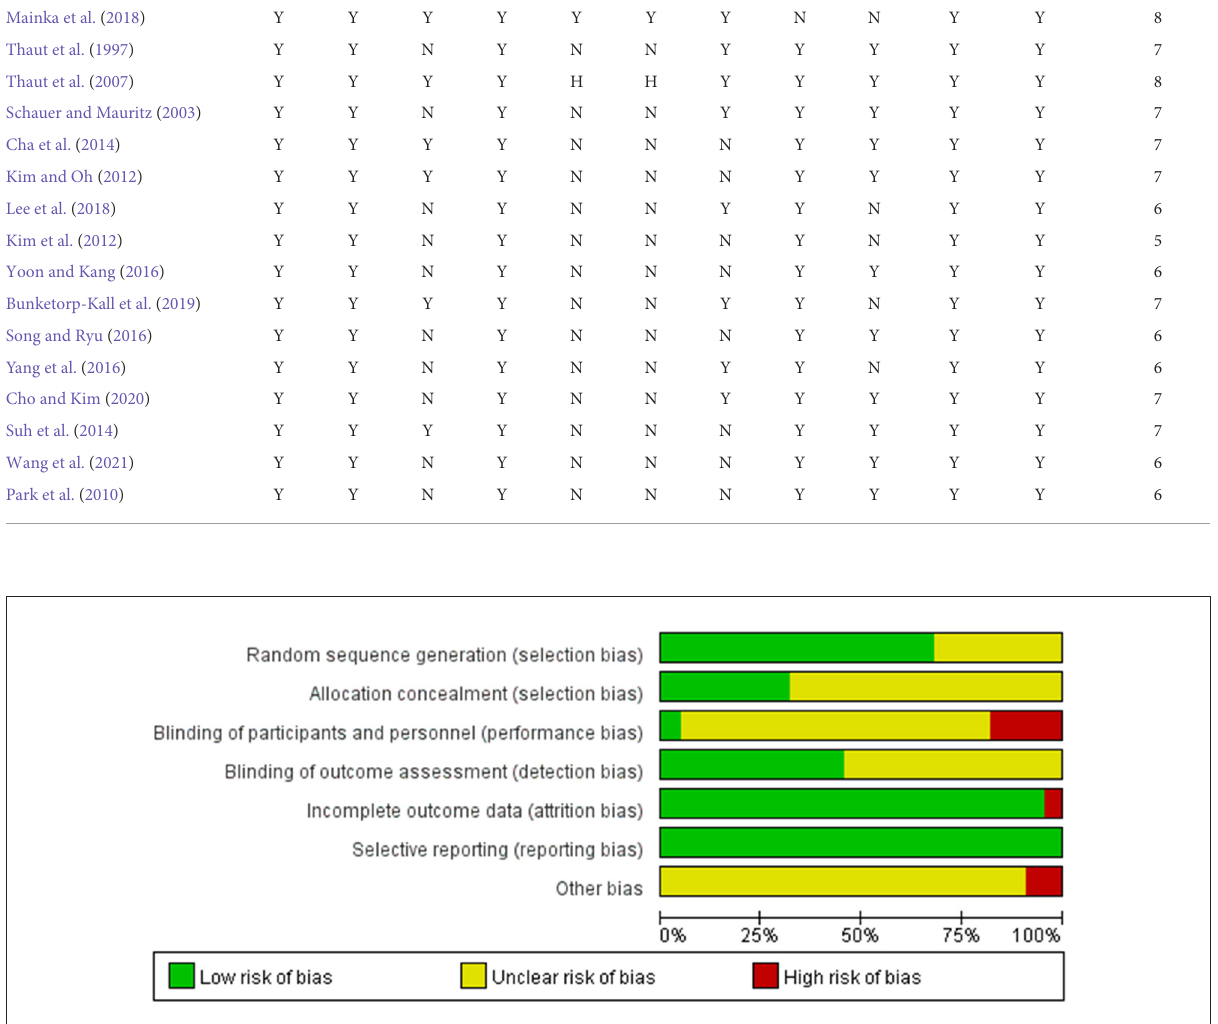
FIGURE2 Risk of bias